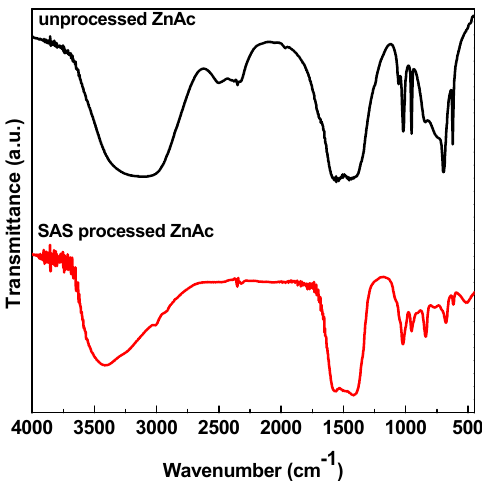
Figure 2. Fourier transform infrared (FT-IR) spectra of unprocessed and supercritical antisolvent (SAS) processed zinc acetate (ZnAc).